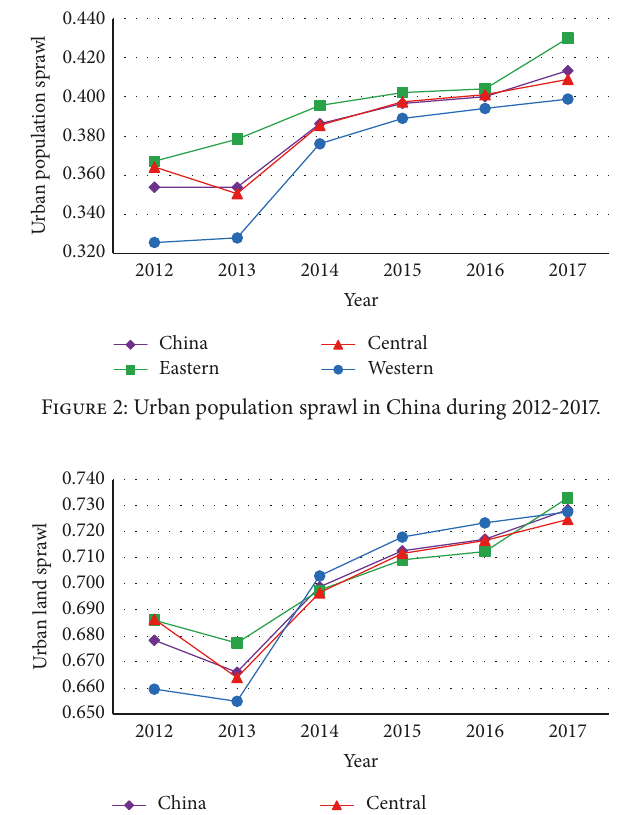
Figure 1: Studying areas.